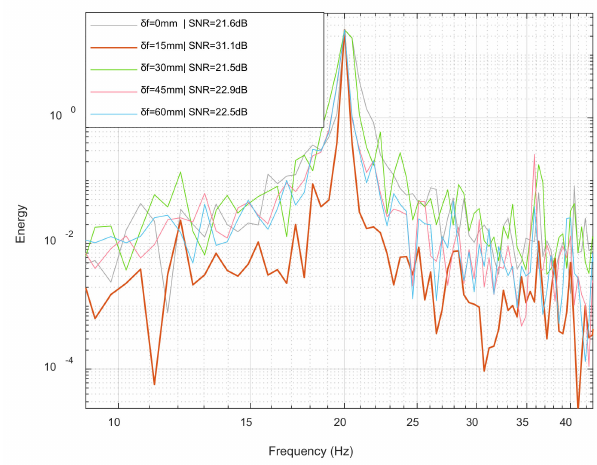
Figure 8. Power spectral density under 0–60 mm defocus